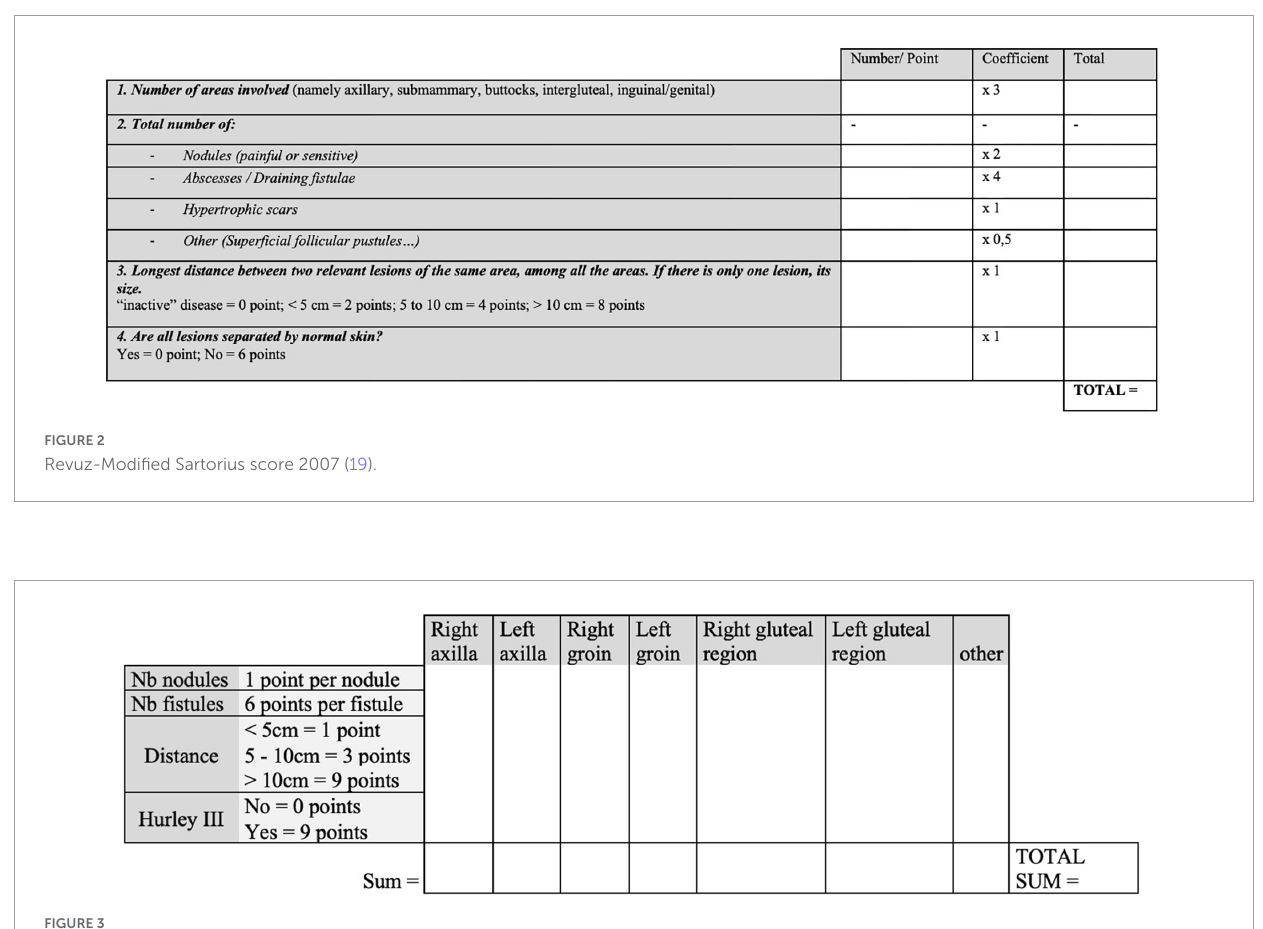
FIGURE3 Modified Sartorius score 2009 (17). Nb, number of; Distance, maximal distance between two lesions in the concerned area.